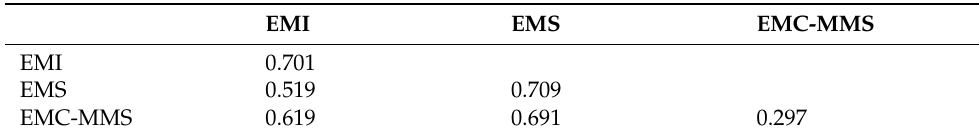
Table 5. Discriminant validity-HTMT.